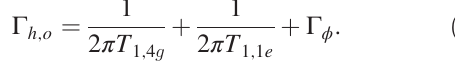
FIG. 3. Optical coherence lifetime under DEOP. (a) Absorption spectra after 0, 1, and 10 s of OP at − 1 . 44 GHz. Inset: Normalized ¼ 0 . 02 (cid:2) 0 . 02 , 2 . 30 (cid:2) 0 . 12 , 0 . 02 (cid:2) 0 . 02 , 1 . 70 (cid:2) 0 . 06 . (b) Absorption spectra after 0, 1, and ground-state populations k 1 , k 2 , k 3 , k 4 g g g g 10 s of OP at þ 2 . 67 GHz. Inset: Normalized ground-state populations k 1 2 . 05 (cid:2) 0 . 08 . (c) Photon echo decays under DEOP for the j 4 g i ↔ j 1 e i transition measured at − 4 . 6 GHz [arrow in panels (a) and (b)]. Decay colors and numbers correspond to spectra in panels (a) and (b); solid lines are exponential fits to the data. (d) Optical coherence times T 2 deduced from fits in panel (c) (color-coded). All error bars correspond to a 95% confidence ;o [Figs. 3(a) and 3(d)]. The corresponding homogeneous ¼ 407 (cid:2) 15 Hz. This is the narrowest linewidth is Γ h;o